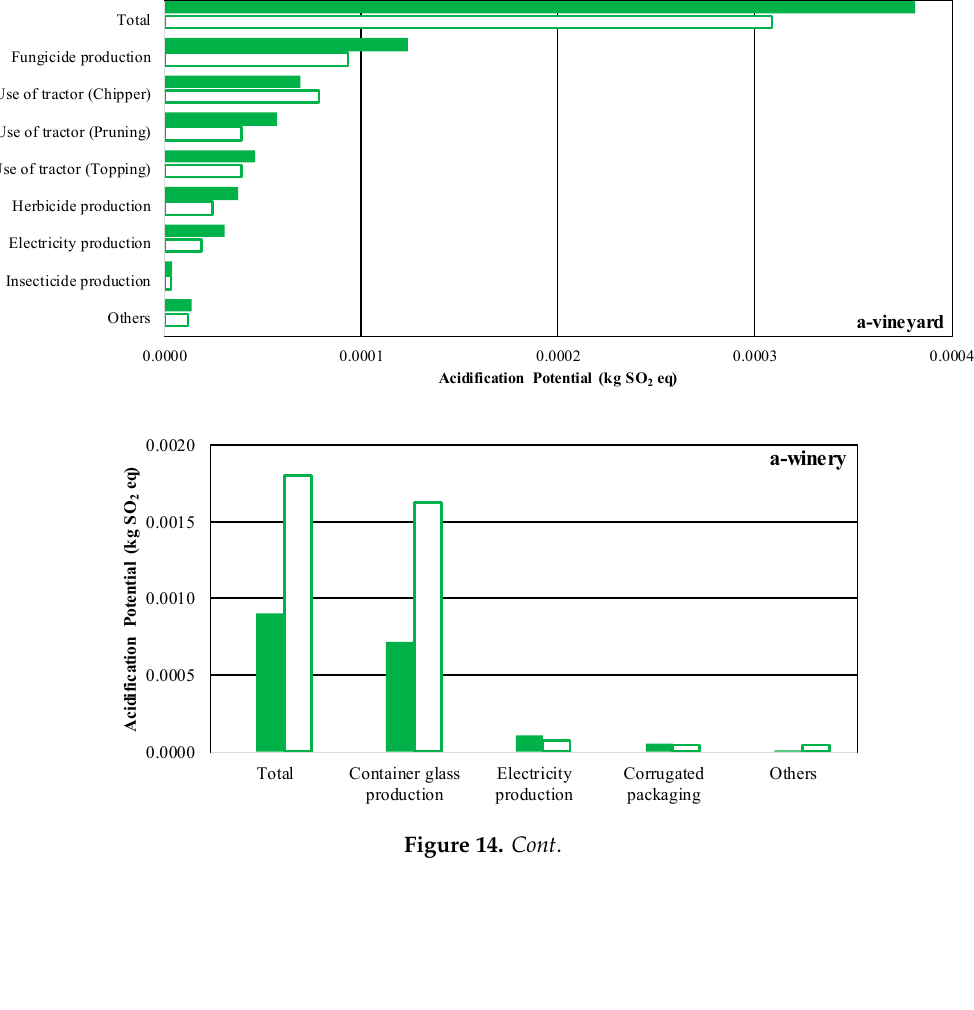
Figure 13. Total blue water footprint (BWF) ( ), water scarcity index (WSI) ( ) and contribution of the different processes linked to the winery stage for ( a ) case study I and ( b ) case study II.